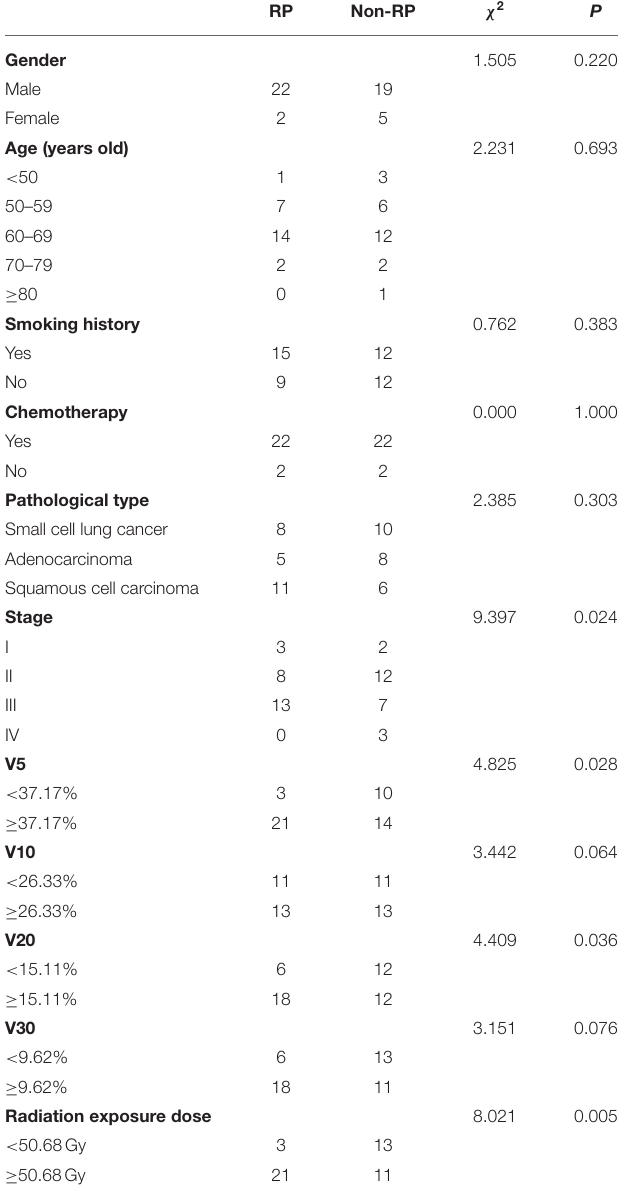
TABLE 1 | Relationship between clinical data and RP.